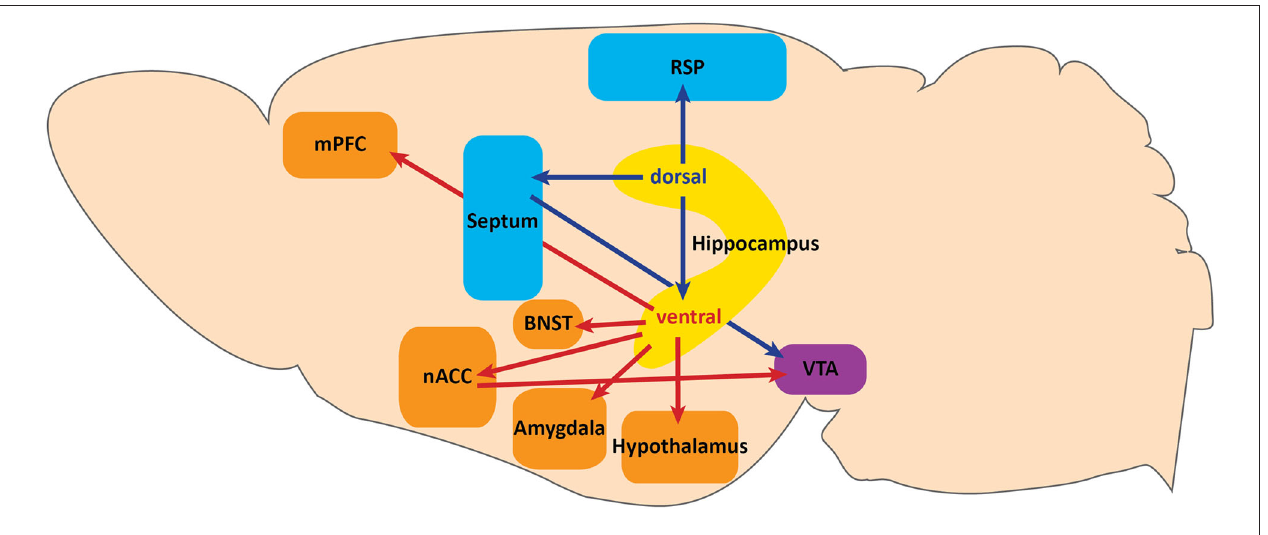
projections to the ventral hippocampus. Projections from the ventral hippocampus include: the medial prefrontal cortex (mPFC), hypothalamus, amygdala, bed nuclues of the stria terminalis (BNST), and the VTA via the nucleus accumbens (nACC). Ventral hippocampal projections function to modulate fear expression and